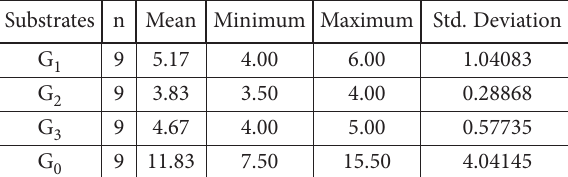
Table 8. Average amount of subsidence in the planting layer according to the substrates (mm) Substrates n Mean Minimum Maximum Std.